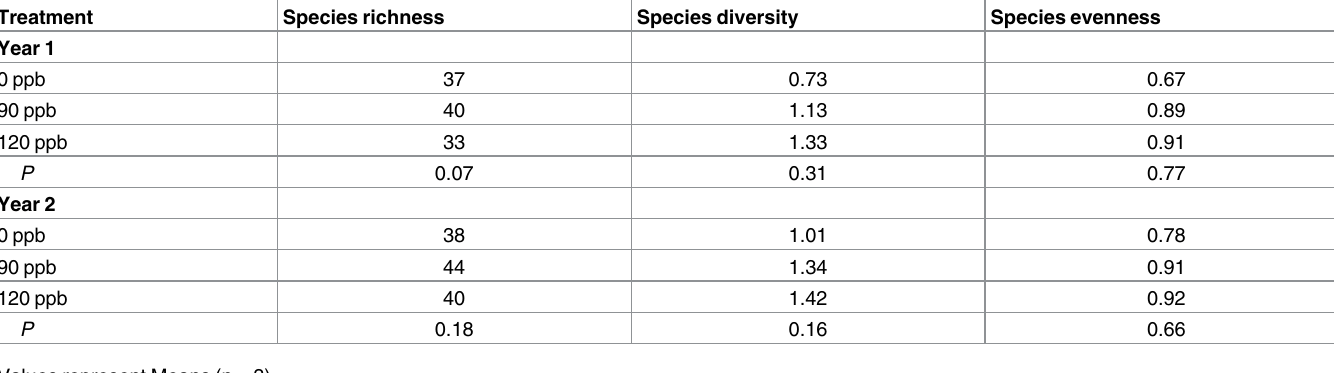
Table 4. Means and statistics from analysis of varianceof species richness ( S ), species diversity (Shannon-Weaver index, H´) and species even- ness ( H ´/log e ( S )) for arthropod communities established from different historic exposure